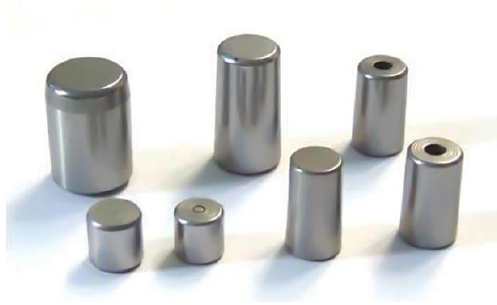
Figure 1. Bearing Figure 1. Bearing rollers.